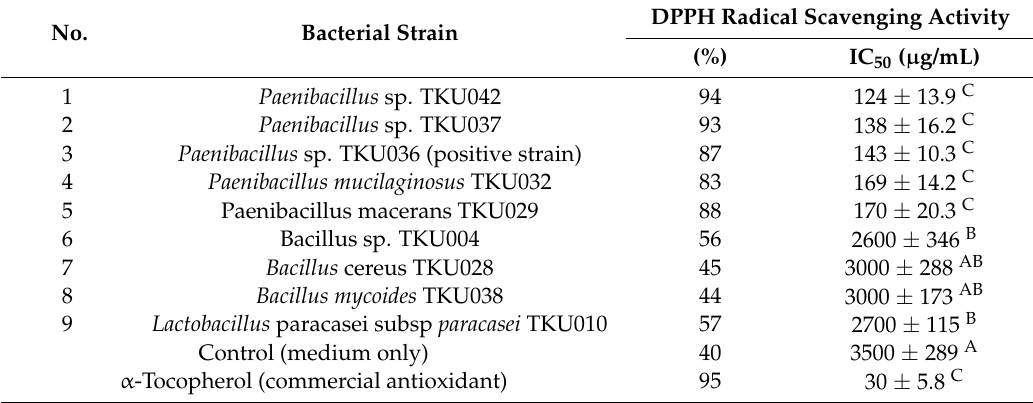
Table 1. Comparison of DPPH radical scavenging activity induced by Paenibacillus species and other chitinolytic and/or proteolytic enzyme–producing bacterial strains.